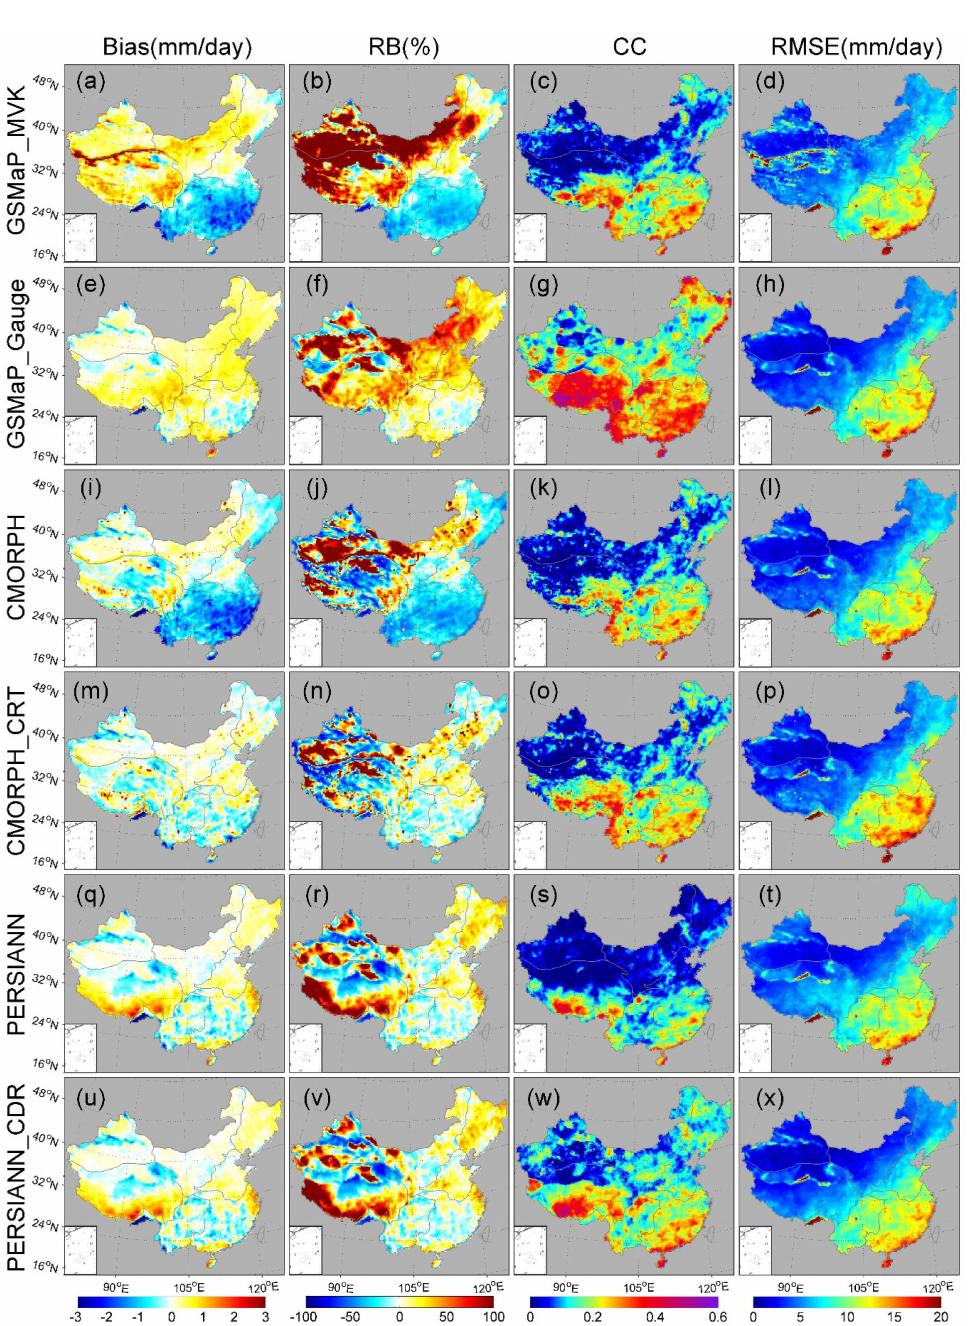
Figure 10. Spatial distribution of Bias, RB, CC, and RMSE between different satellite-based products and CPAP over China on a 0.25 ˝ lat/lon grid for ( a – d ) GSMaP_MVK; ( e – h ) GSMaP_Gauge; ( i – l ) CMORPH; ( m – p ) CMORPH_CRT; ( q – t ) PERSIANN; and ( u – x )